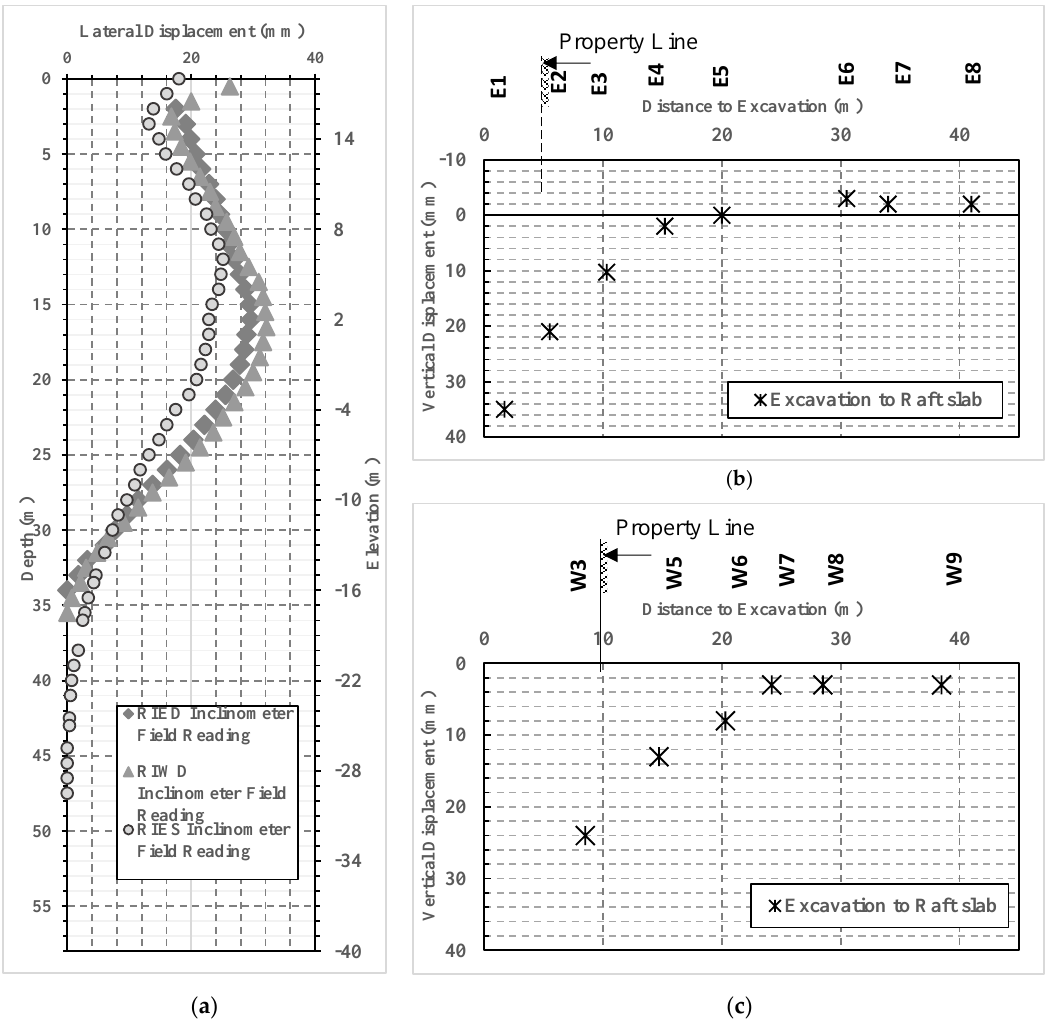
Figure 6. Summary of in-situ measurements of walls lateral deformation and ground surface settlement for both the west and east sides. ( a ) Lateral diaphragm wall displacement at East (RIED) and west (RIWD) sides. ( b ) Settlement profile adjacent to the excavation on the east side. ( c ) Settlement profile adjacent to the excavation at the west side.